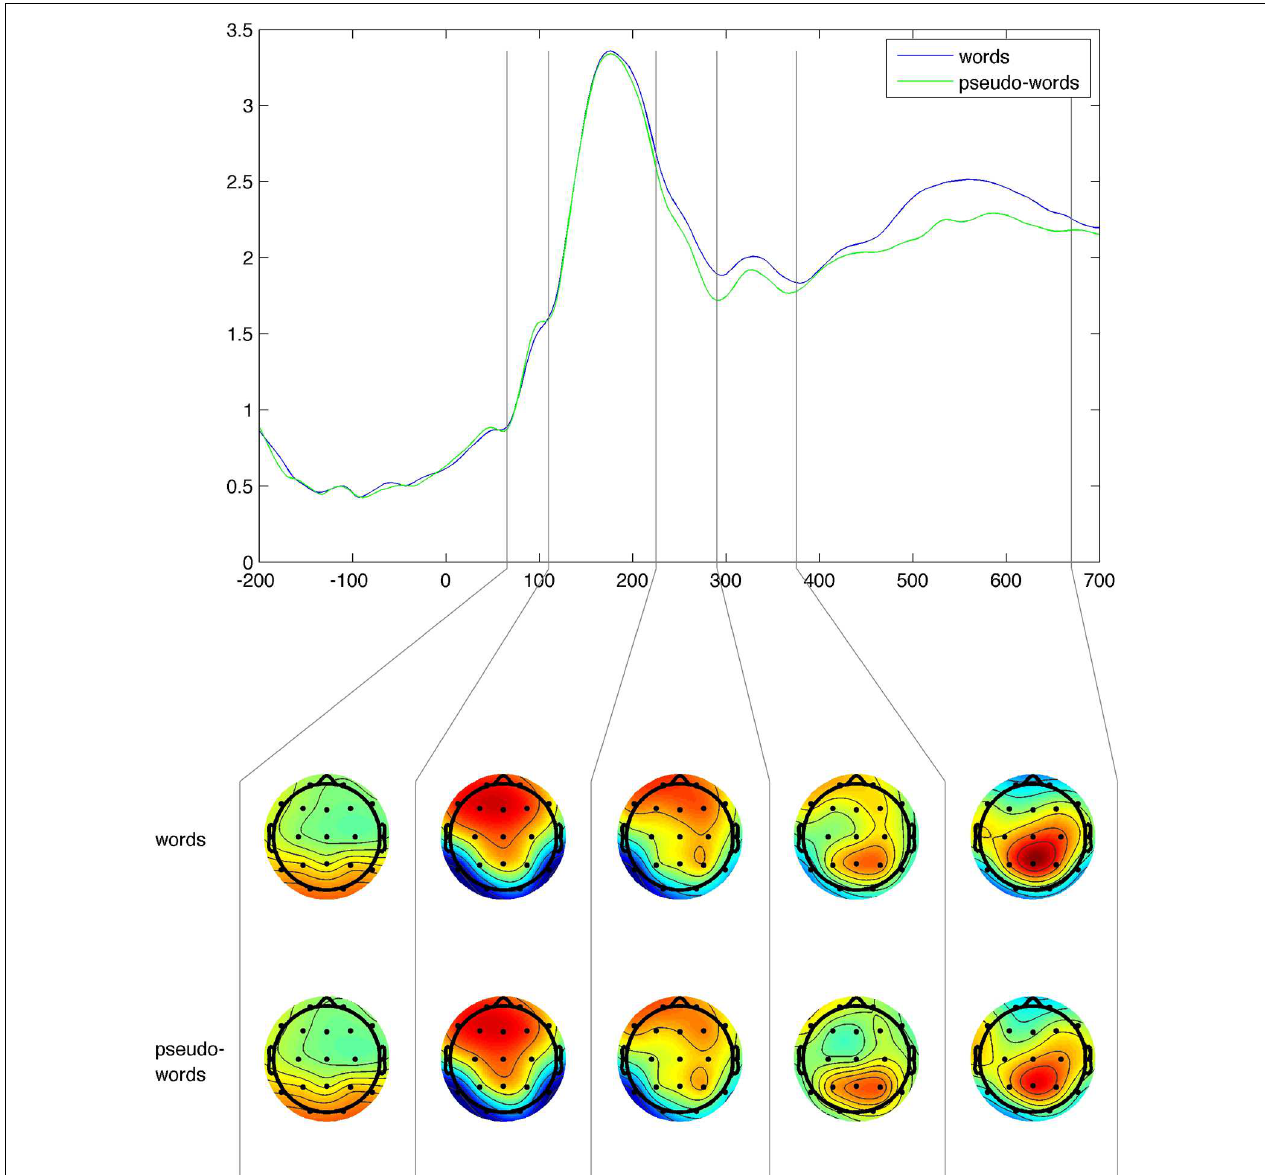
FIGURE 2 | Global field power (upper plot) and mean amplitude topographies (two bottom rows) for word and pseudo-word stimuli. The vertical lines in the upper plot mark the boundaries of time